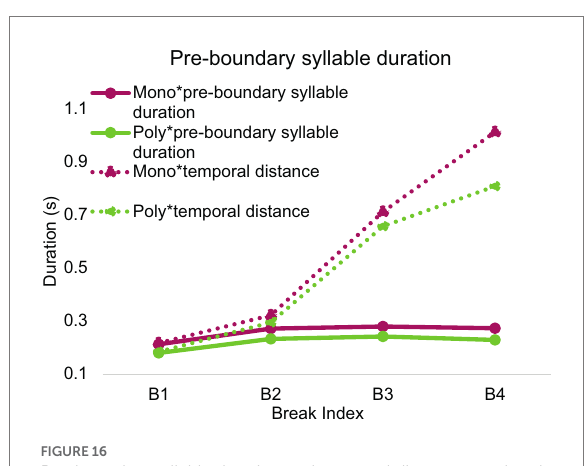
FIGURE 16 Pre-boundary syllable duration and temporal distance over break index in Mandarin.